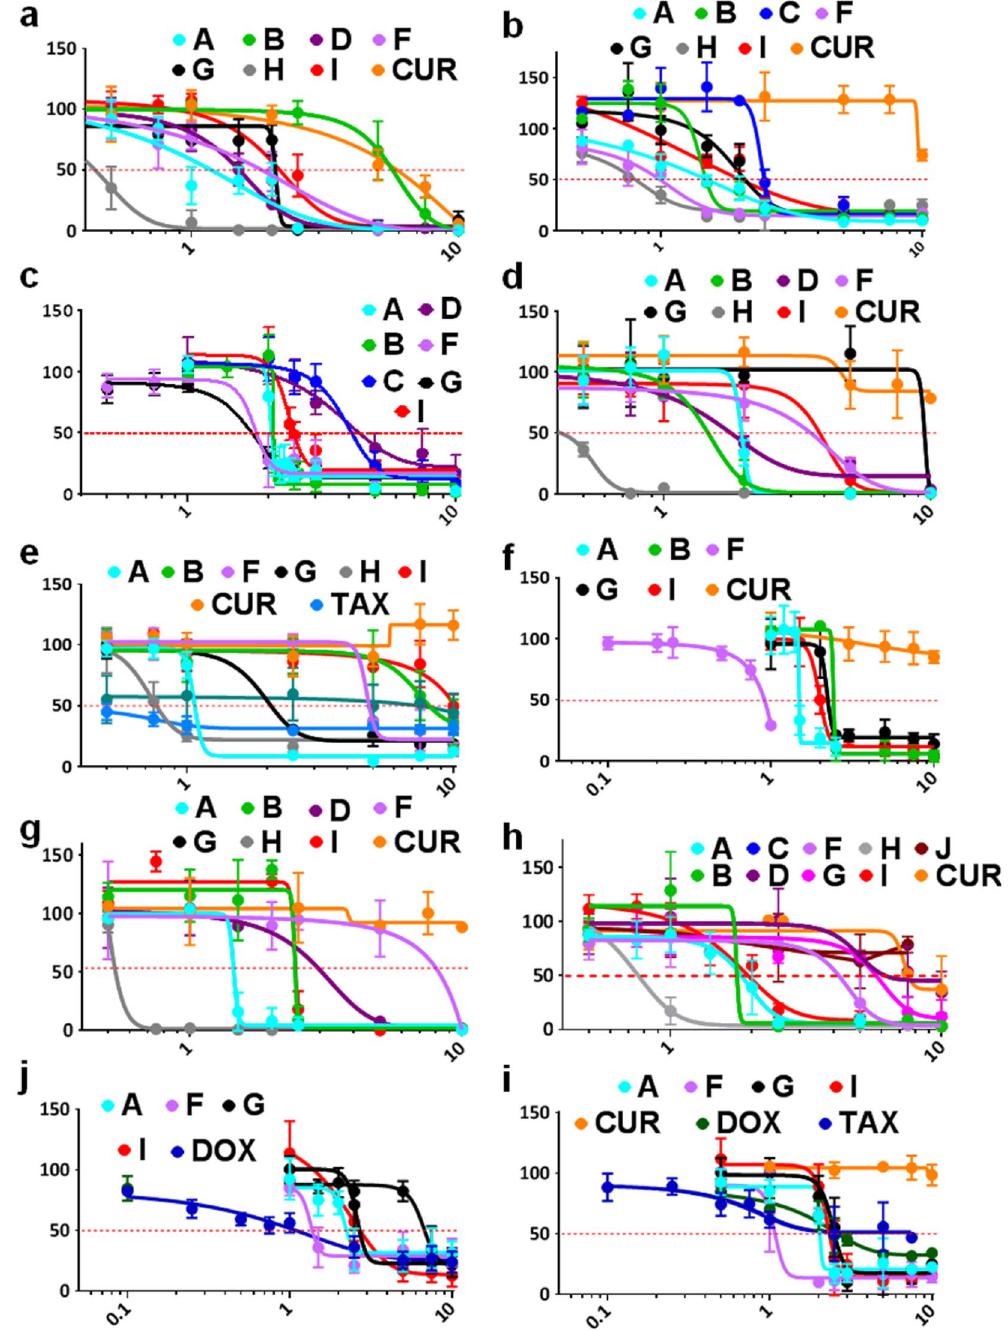
Figure 2. Curcumin Analogs Display Broad Efficacy in Reducing Cell Viability in 10 Cancerous Cell Lines Compared to Natural Curcumin. Cells were treated with various doses of curcumin, curcumin analogs, or common chemotherapeutics for 48 hours. Following treatment, WST-1 cell proliferation assay was used and the absorbance at 450 nm was measured. Y-axis is the percent mean ± SD from three independent experiments to the DMSO control and the x-axis is the concentrations used in micromolar. Results graphed using the log(inhibitor) vs response – Variable slope (four parameters) curve using GraphPrism6. ( a ) MV-4-11 ( b )